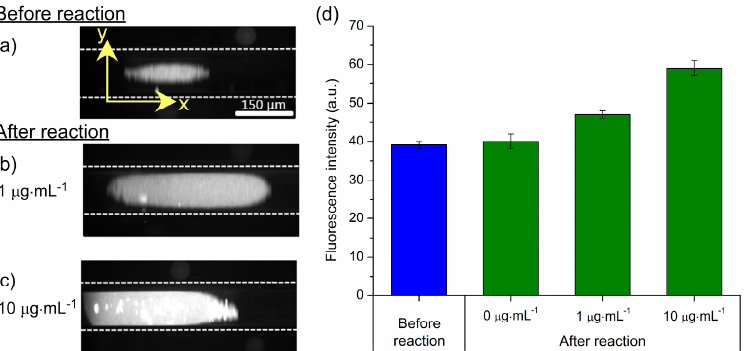
Figure 7. Results obtained via a magnetic particle plug-based sandwich assay for C-reactive protein (CRP). ( a ) Fluorescence image of a particle plug prior to the CRP assay, demonstrating the auto-fluorescence of the polystyrene-based particles. Magnetic particles were functionalised with primary CRP antibodies (1° anti-CRP). ( b ) Fluorescence exhibited by a particle plug after exposure to 1 µg·mL − 1 CRP and subsequent labelling with fluorescently tagged secondary CRP antibody (2° anti-CRP-FITC; 100 µg·mL − 1 ); and ( c ) after exposure to 10 µg·mL − 1 CRP and labelling with 2° anti-CRP-FITC (100 µg·mL − 1 ). ( d ) Plot of fluorescence intensities of the particle plugs at varying concentrations of CRP.